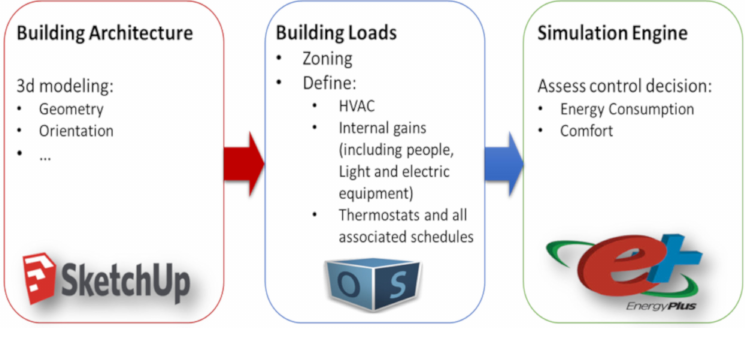
Figure 3. Simulation